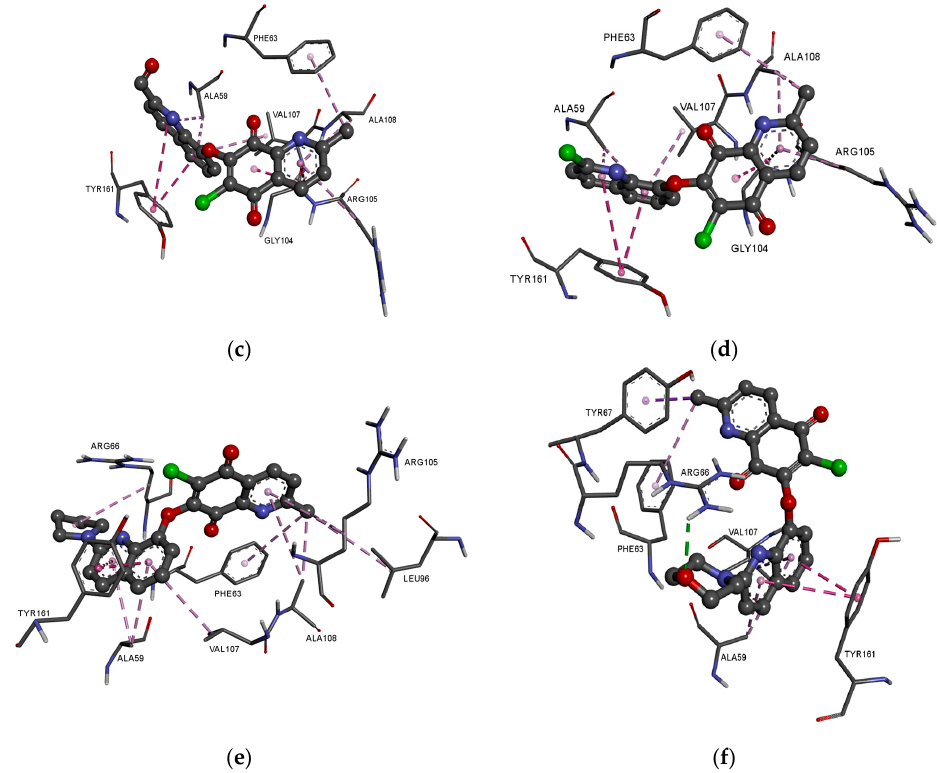
Figure 8. Docking pose of the BCL-2 protein complex with hybrids: ( a ) 13 ; ( b ) 14 ; ( c ) 15 ; ( d ) 16 ; ( e ) 17 ; ( f ) 18 .